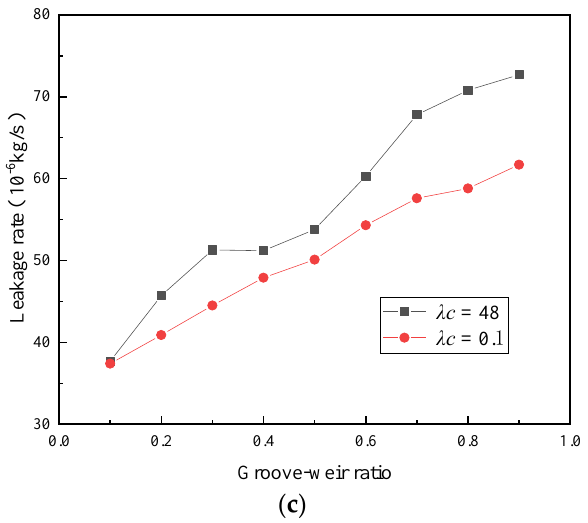
Figure 7. Effect of groove-weir ratio on sealing performance. ( a ) Effect on the average vapor phase volume fraction. ( b ) Effect on the opening force. ( c ) Effect on leakage rate.